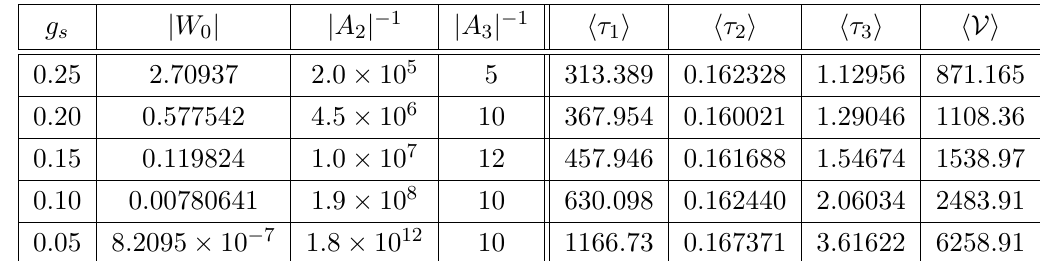
W 0 , A 2 and A 3 and corresponding stabilised values of j j j j j j